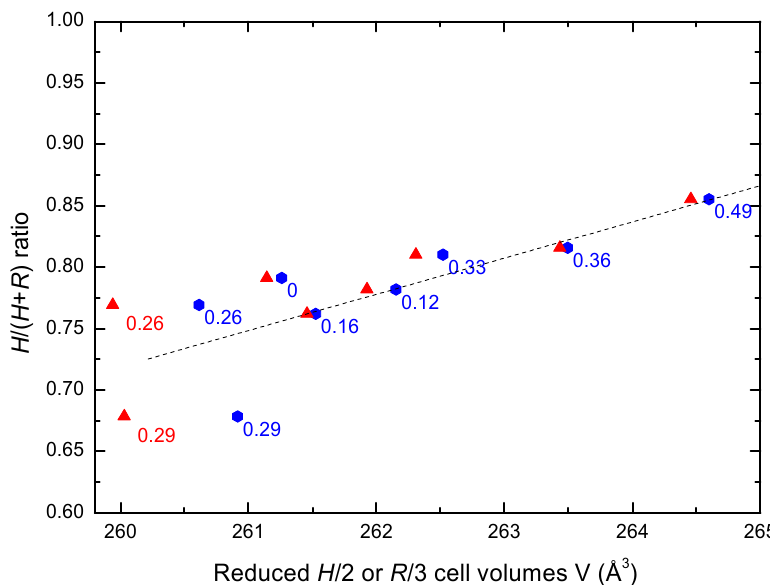
Figure 2. Evolution of the H /( H + R ) ratio (%) as a function of the reduced cell volumes ( V H /2 (blue circle) and V R /3 (red triangle) for Sm 2 Mn x Ni 7 − x (0 ≤ x ≤ 0.49). The x values are given directly on the graph. The dotted line represents a linear adjustment of the data.